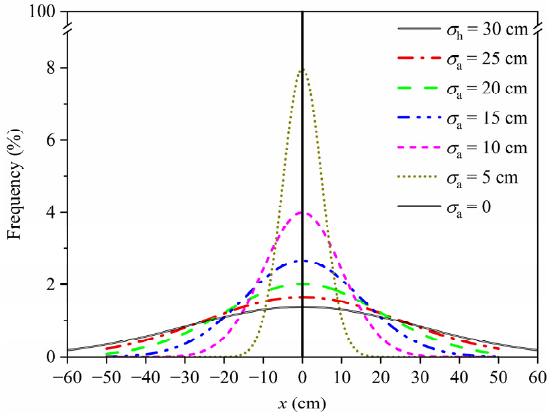
Figure 7. PDF of transverse distribution of vehicles.